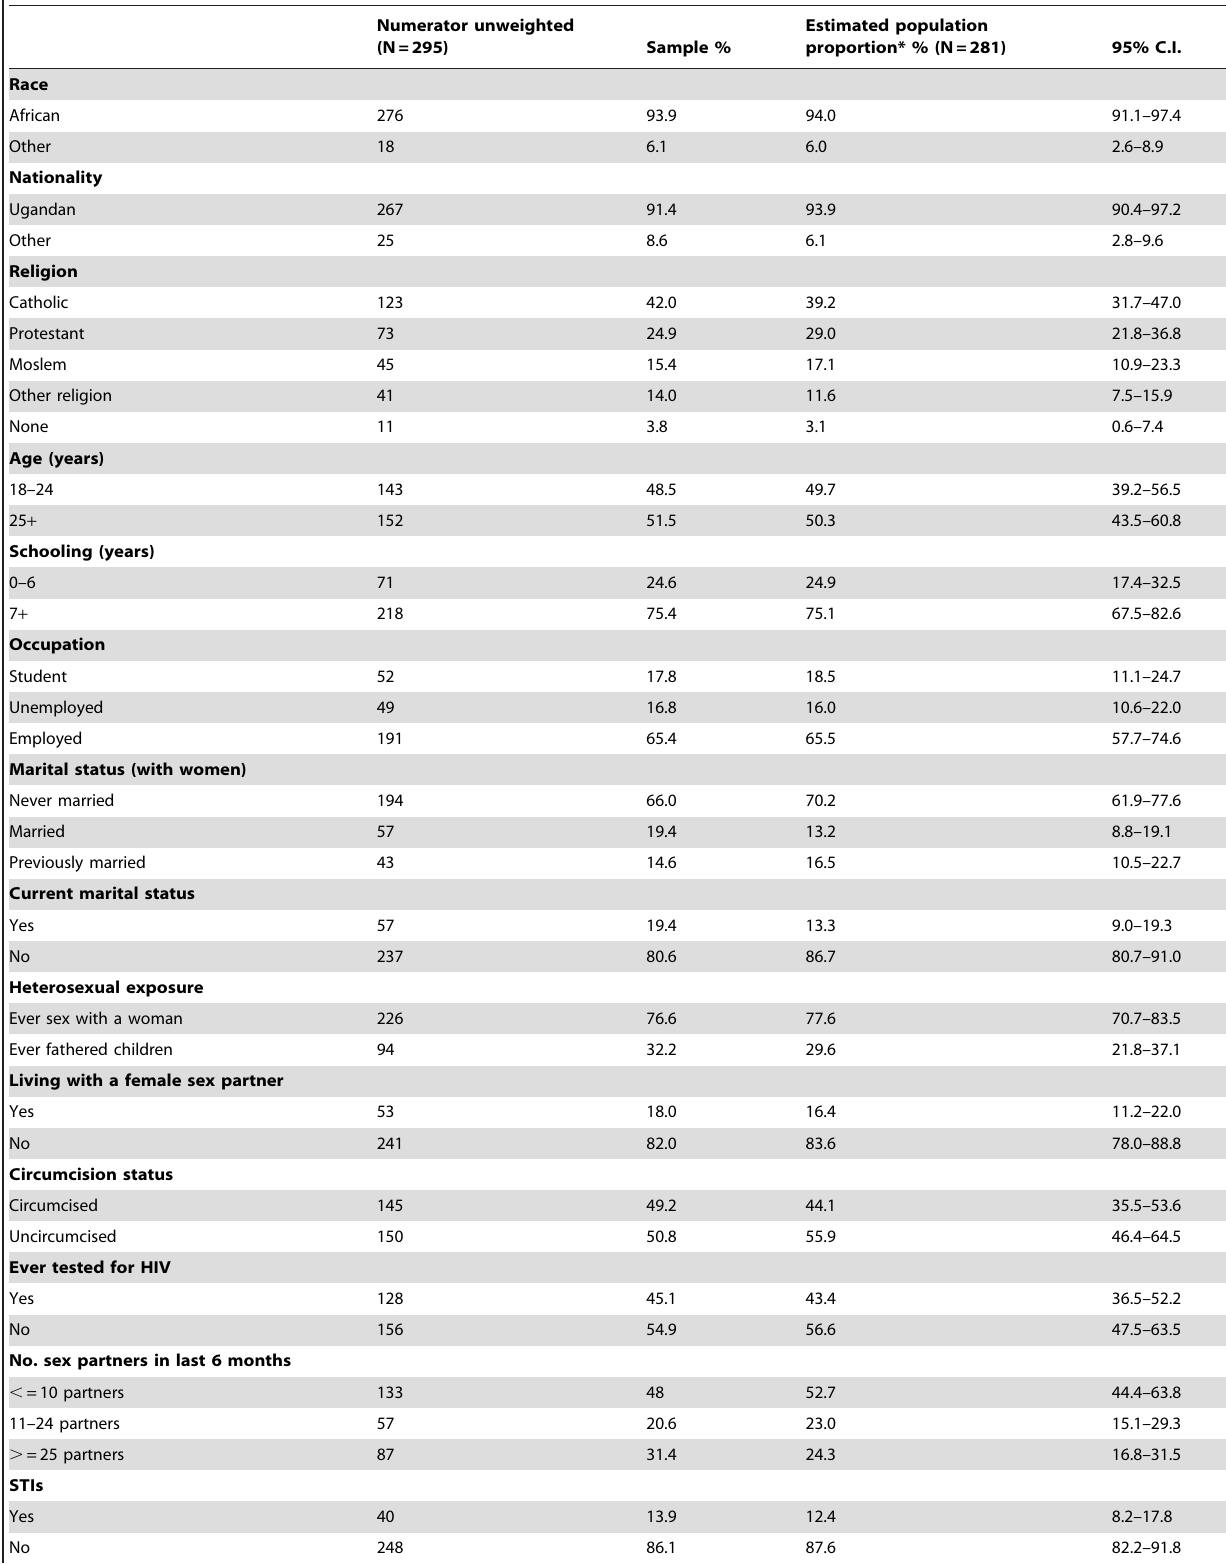
Table 1. MSM characteristics, Kampala, Uganda, 2008/9.